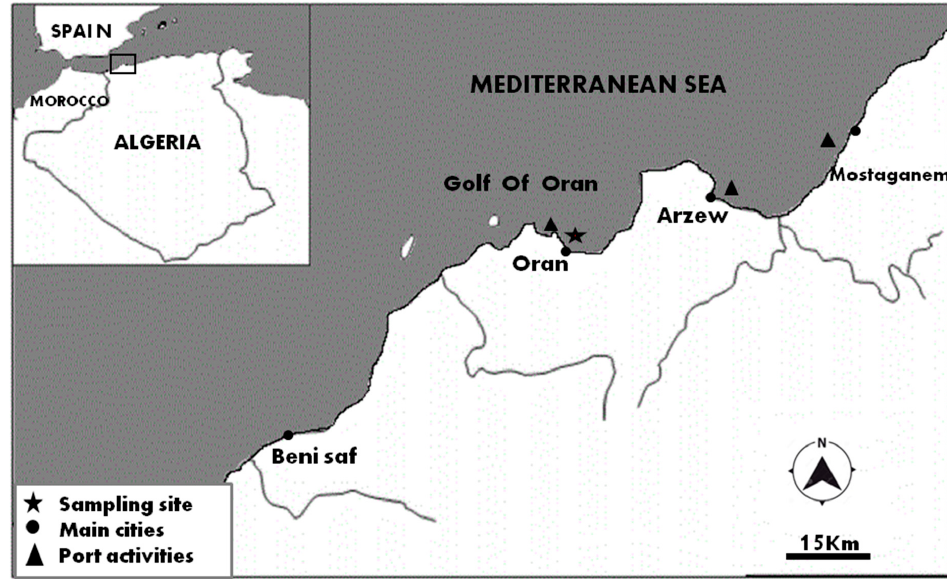
Figure 1. Localization of the chronically-contaminated sampling site.